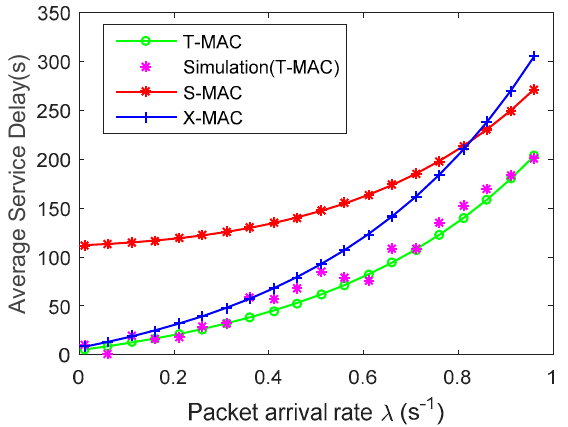
Figure 5. The average service delay with respect to the packet arrival rate ⋋ for the T-MAC, S-MAC and X-MAC protocols.